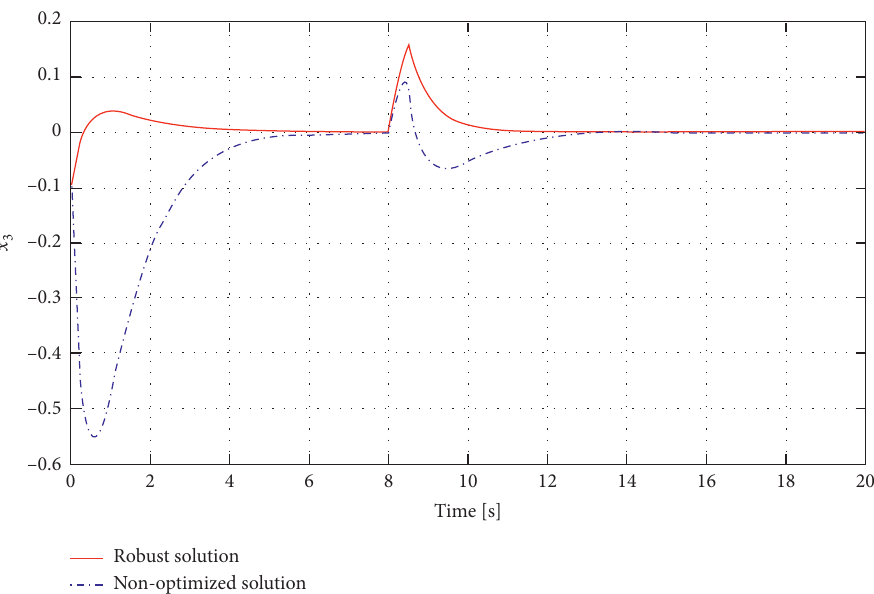
Figure 4: Comparison of x